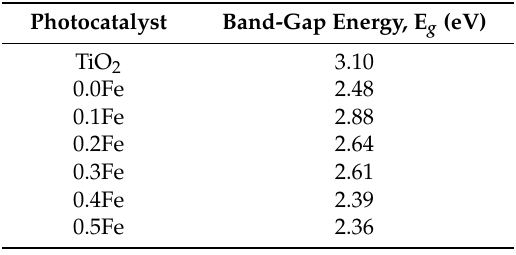
Figure 3. XRD analysis for the photocatalyst with different amounts of Fe content.